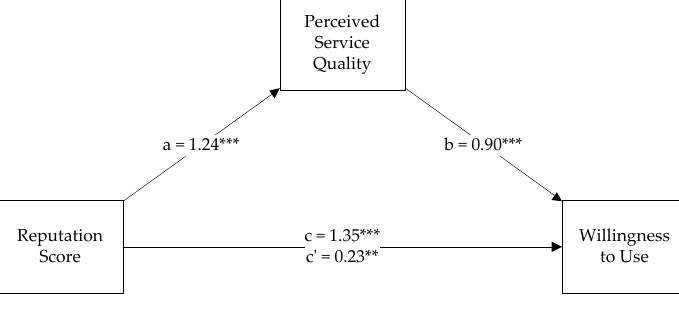
Figure 1. Mediation model. ** p < 0.01. *** p < 0.001.